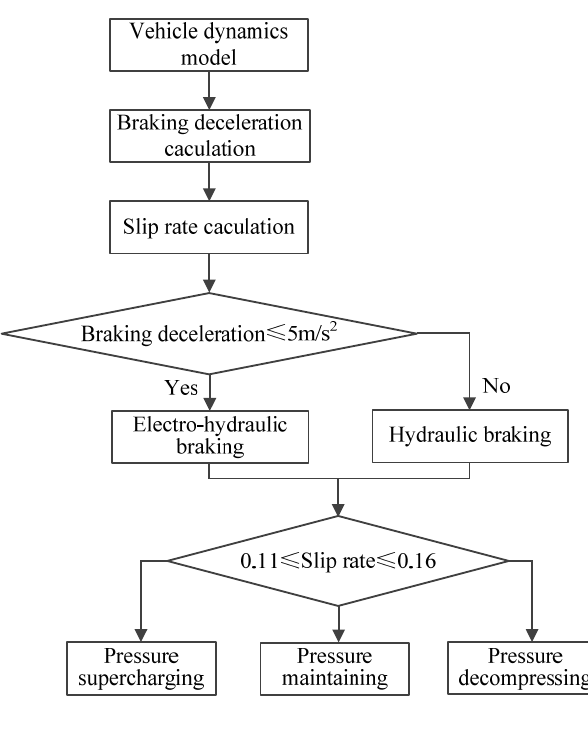
Figure 4. Electro-hydraulic braking control